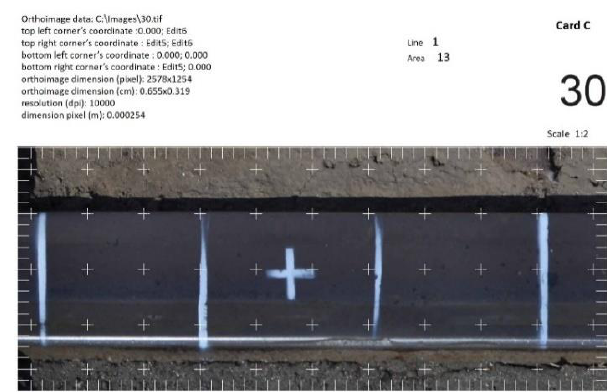
Figure 11. Orthophoto of the investigated